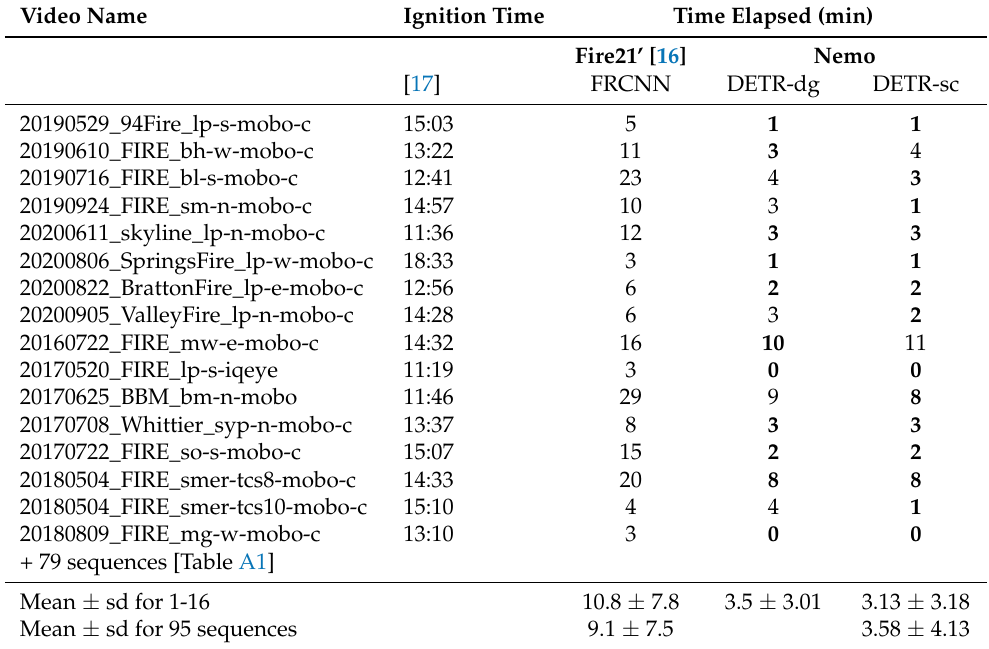
Table 8. Incipient stage first smoke detection analysis. Sixteen smoke sequences extracted from the HPWREN database [17] and 79 sequences extracted from a collection of HPWREN images [102]. The earliest detection for each case study is marked in